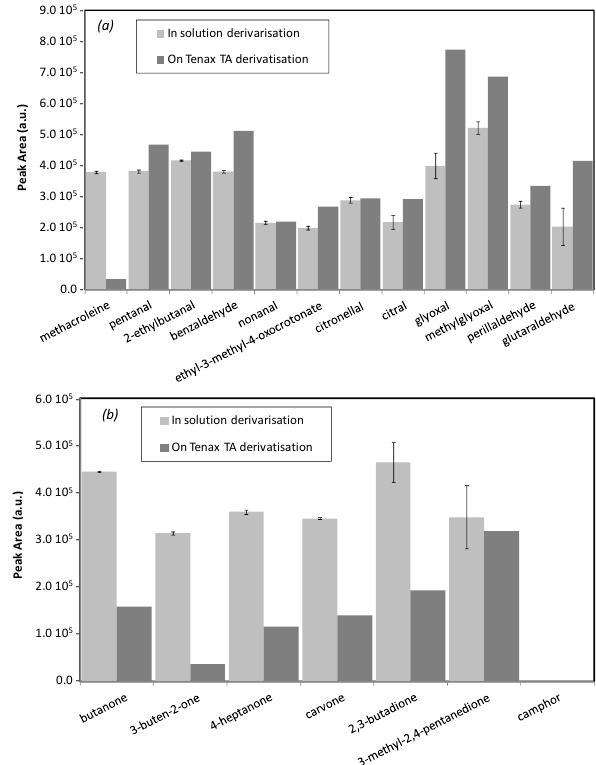
Fig. 7. Comparison of results for in-solution and on-Tenax TA carbonyl compound PFBHA derivatisation: (a) aldehydes derivatisation results, (b) ketone derivatisation results. “Peak Area” refers to FID chromatogram, in area units. Error bars represent ± one standard deviation determined from four replicates of in-solution derivatisation. On-Tenax TA derivatisation was performed twice. Derivatised camphor was not detected by both methods.